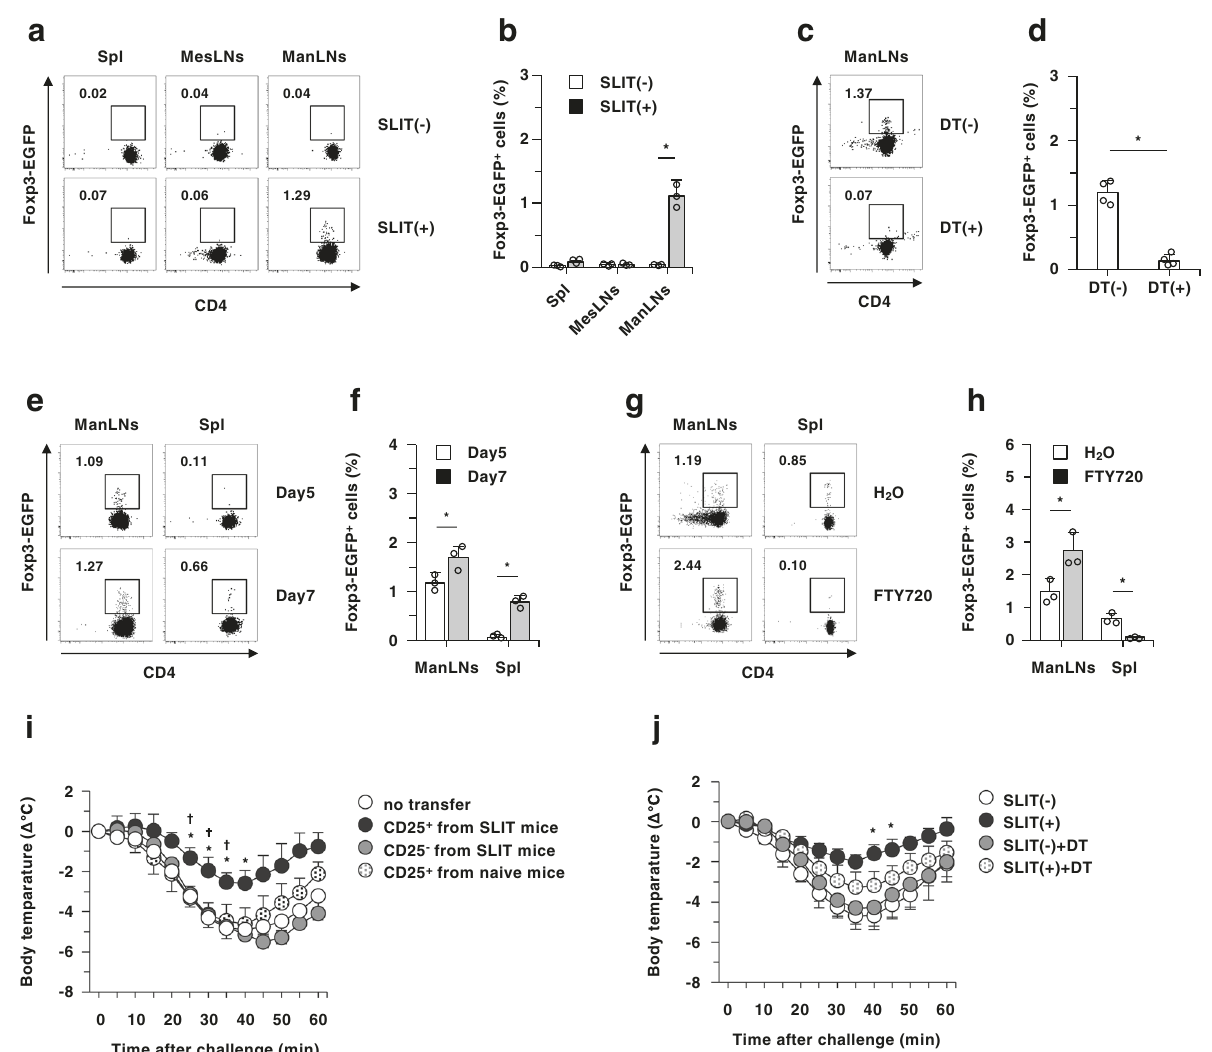
Fig. 4 De fi ciency of cDCs abrogates de novo generation of antigen-speci fi c CD4 + Foxp3 + pT reg cells in vivo. a – h WT mice a , b , e – h , CD11c-DTR/EGFP mice that had been treated with PBS c , d or DT c , d were adoptively transferred with CD45.1 + OT-II CD4 + Foxp3 EGFP − T cells, and then mice were sublingually administered with OVA protein. The expression of Foxp3 EGFP on CD45.1 + OT-II CD4 + T cells in spleen, MesLNs, and ManLNs were analyzed at 5 days a – f or 7 days e , f after the administration. g , h WT mice were daily administrated with or without FTY720, and the expression of Foxp3 EGFP on CD45.1 + OT-II CD4 + T cells in spleen and ManLNs were analyzed at 7 days after the administration. Cell surface expression pro fi le a , c , e , g and proportion b , d , f , h of CD45.1 + OT-II CD4 + Foxp3 EGFP + T cells. i CD4 + CD25 + T cells or CD4 + CD25 − T cells obtained from WT mice that had been treated with or without sublingual immunization of OVA were adoptively transferred into WT mice, and then mice were systemically immunized with OVA protein at 1 day and 8 days after the transfer. Subsequently, mice were challenged i.p. with OVA protein at 10 days after the last immunization, and the rectal temperature were monitored. j DEREG mice that had been treated with or without sublingual immunization of OVA were administrated with or without DT at 7 days after SLIT, and then mice were systemically immunized with OVA protein at 15 day and 22 days after DT injection. Subsequently, mice were challenged i.p. with OVA protein at 10 days after the last immunization, and the rectal temperature were monitored. Data are obtained from fi ve individual samples in a single experiment. * P < 0.05 compared with normal mice b indicated as SLIT( − ), CD11c-DTR/EGFP mice that had been treated with PBS indicated as DT ( − ) d , among groups f , h WT mice (no transfer) i , or DEREG mice immunized with OVA protein indicated as SLIT( − ) j . † P < 0.05 compared with CD4 + CD25 + T-cell transfer from naive mice i . All data are representative of at least three independent